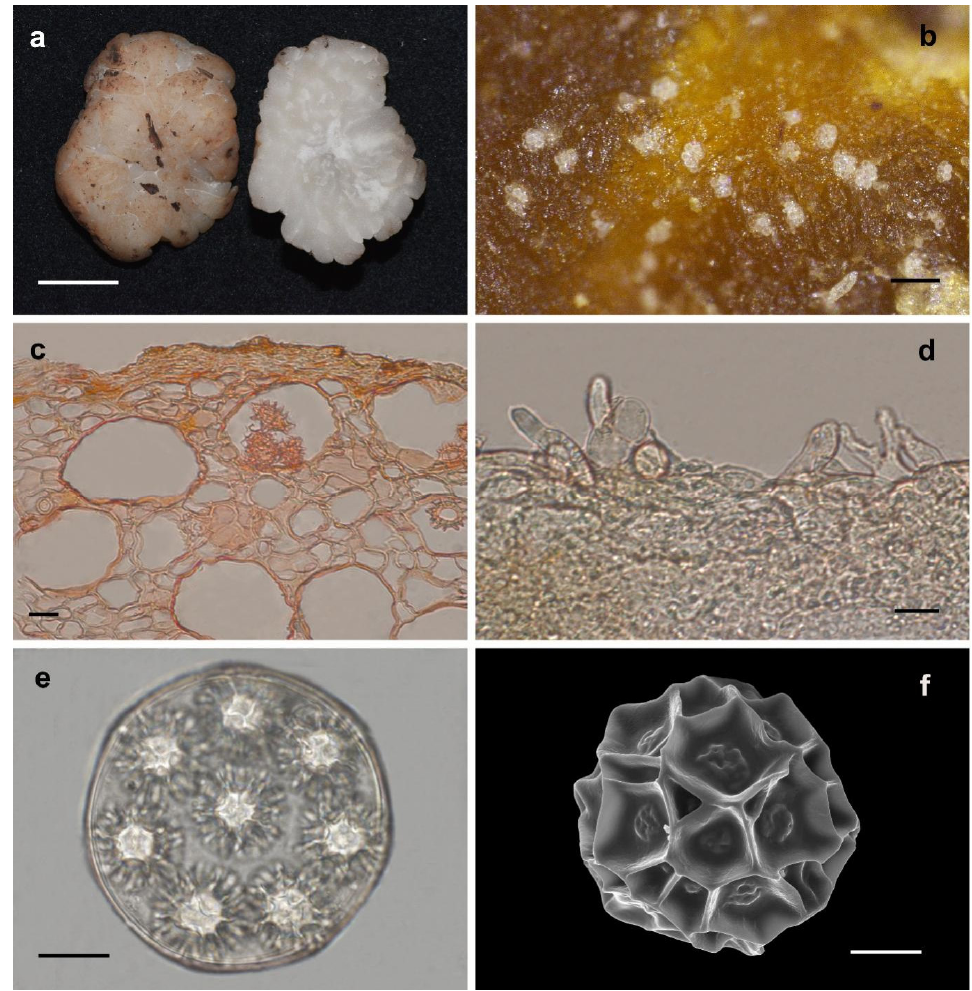
Figure 7. Hydnobolites tenuiperidius (Holotype, YNAU0899). ( a ) Fresh ascoma and gleba; ( b ) surface of dried ascoma; ( c ) peridium; ( d ) paraphyses; ( e ) ascus and ascospores under LM; ( f ) ascospore under SEM. Scale bars: a = 1 cm; b = 0.1 mm; c–e = 20 µm; f = 5 µm. 3.2.6. Hydnobolites cerebriformis Tul., Tul., Annales des Sciences Naturelles Botanique 19: 378 (1843) [1] (Figure 8). MycoBank: 2389